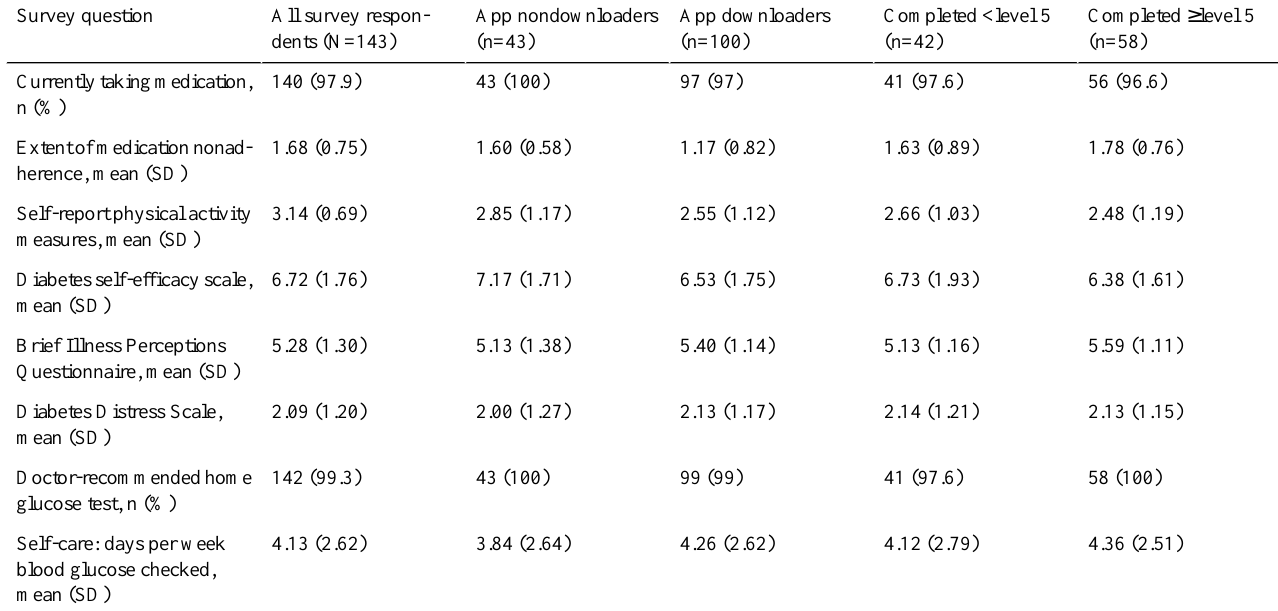
Table 3. Survey results across levels of